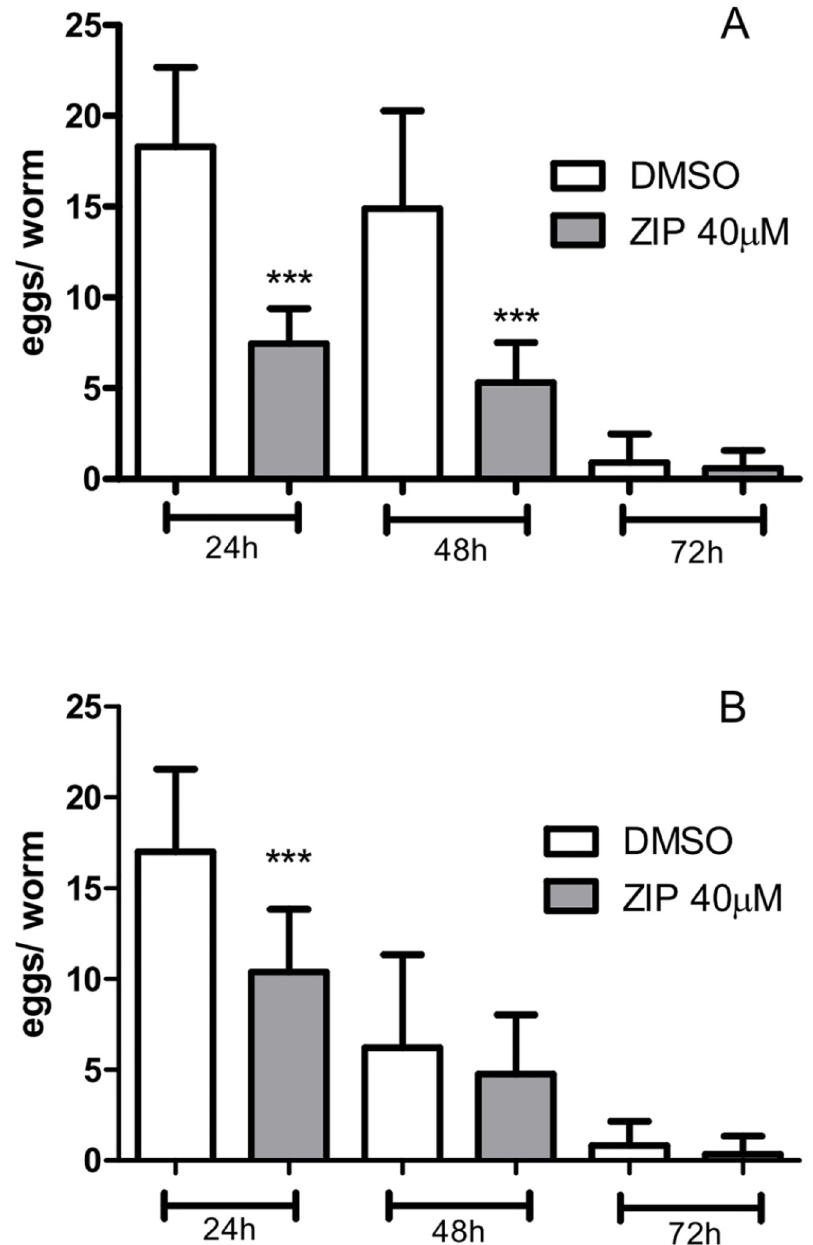
Figure 6. Reproductive behavior of the nematode C. elegans under Ziprasidone exposition. (A) The egg production and (B) egg laying were observed after 24, 48 and 72 hours of Ziprasidone treatment (40 µM) or vehicle as control (DMSO 0.16% in Acetic acid (1:10 000)) (mean, SD, n> 20)). The results represent the mean of eggs inside the worm (A) and the mean of the eggs released during 2 h in different time of treatment (24, 48 and 72 hours). ***p<0.0001, statistically different when compared to respective control of each exposition time by one way ANOVA with Bonferroni correction for post hoc multiple comparisons.